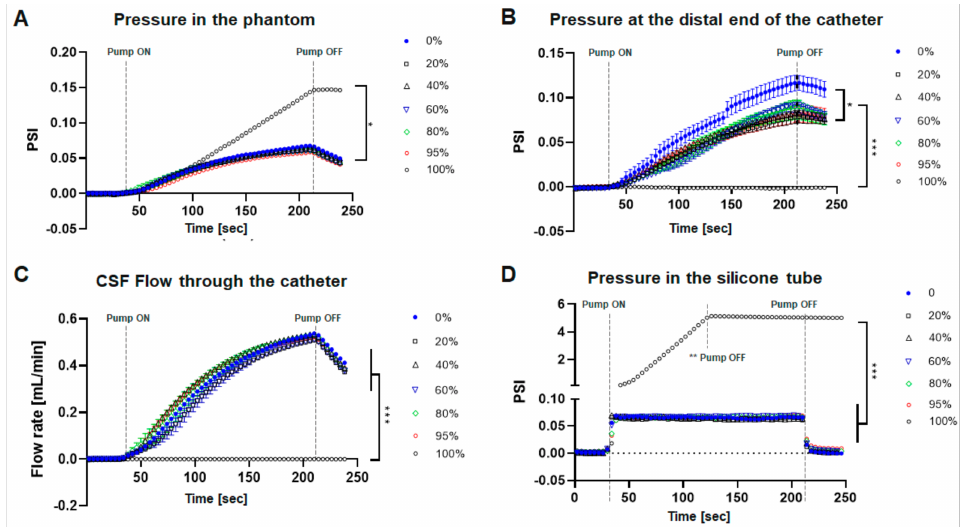
Figure 2. Catheter performance after epoxy obstruction. ( A ) Intraventricular pressure associated with barium striped silicone catheter malfunction due to epoxy resin obstruction. No significant differences were found between partially obstructed catheters and patent catheters. Significant differences were only found in 100% obstructed when compared with the rest of the conditions (*** p < 0.001). ( B ) Pressure measured at the distal end of the catheter obstructed by epoxy resin. Significant differences were found between 0% epoxy-obstructed catheters (* p < 0.05) and all the partially obstructed catheters, indicating that partial obstruction significantly reduced the outflow pressure of the catheter even though only 20% of the catheter holes were obstructed; 100% obstructed catheters significantly reduced the outflow pressure to 0 (*** p < 0.001). ( C ) The flow rate of CSF in the obstructed catheter. No significant differences were found according to the change in the degree of catheter obstruction. Only 100% obstructed catheter has no flow due to complete epoxy resin occlusion (*** p < 0.001). ( D ) Pressure measured in the silicone tubes instead of the phantom. The response time * to react to the given CSF input is 6 s. (* Time to reach maximum pressure). (** The pump was turned off beforehand to avoid sensor failure due to excessive pressure build-up in the silicone